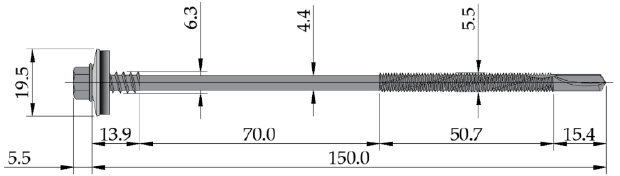
Figure 2. The geometry of the self-drilling fastener (dimensions are in mm).